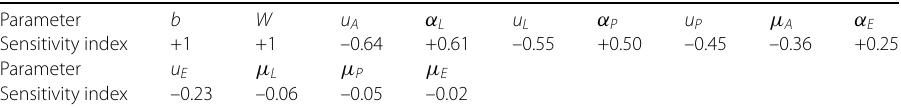
Table 1 Sensitivity index of the basic reproduction number Parameter